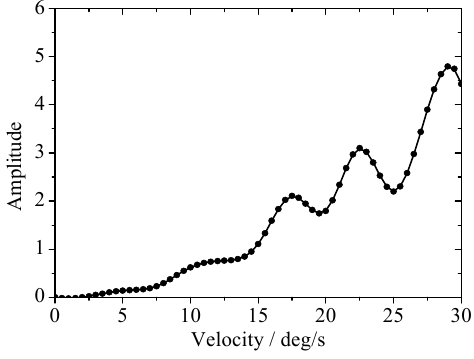
Figure 9. Radial vibration amplitude of planetary gears at different rotational velocities.